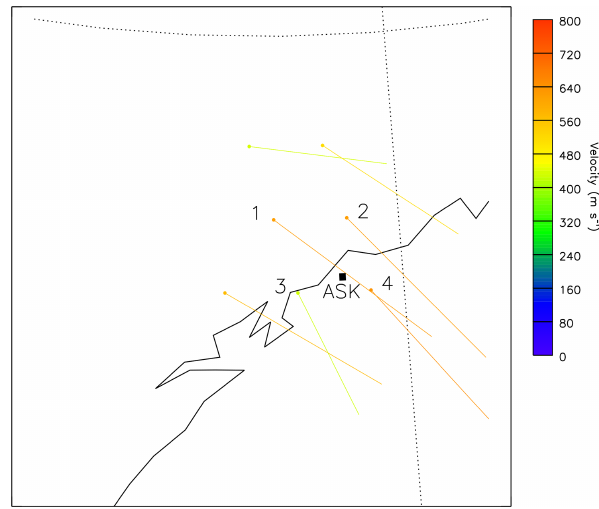
Figure 9. Merged plasma velocities over northern Scandinavia ob- tained between 21:24 and 21:26UT on 9 November 2006. The grey line approximates the coastline of Norway, and the dotted lines are magnetic latitude and longitude. The red dots are at the position of the measured velocities, and the direction of the velocity is given by the direction of the line from the dot. The length and colour of the lines indicate the magnitude of the plasma velocities. The black square is the approximate size and location of the ASK field of view at 200km altitude. The vectors labelled 1–4 are those clos- est to ASK as listed in Table 1. The SuperDARN data used in this figure were processed using RST version